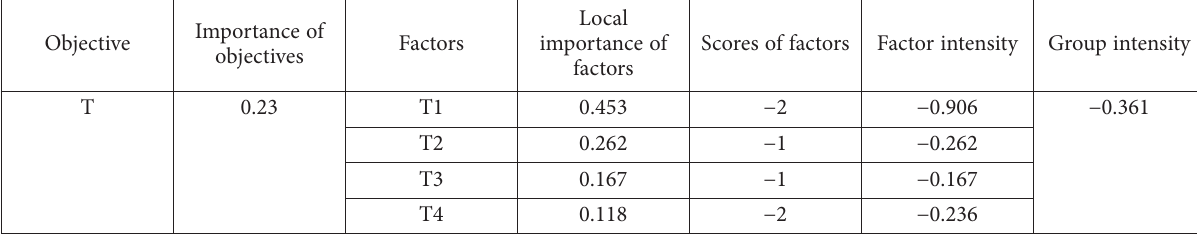
Table A5. Intensity for threat factors and groupings in SNC (one